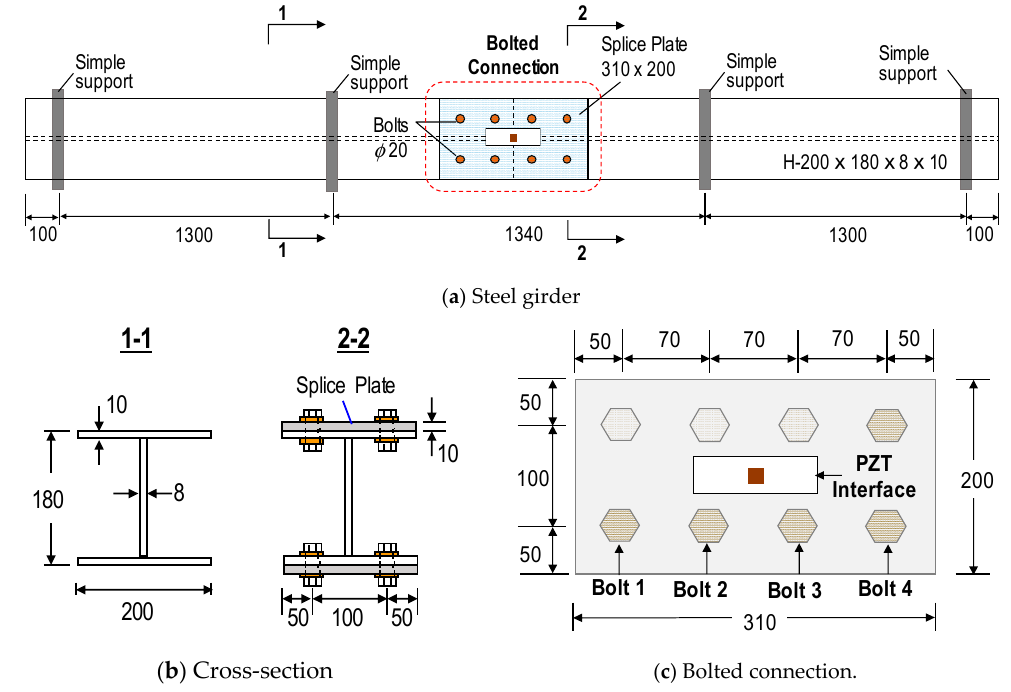
Figure 9. Schematic of the bolted girder connection (unit: mm).